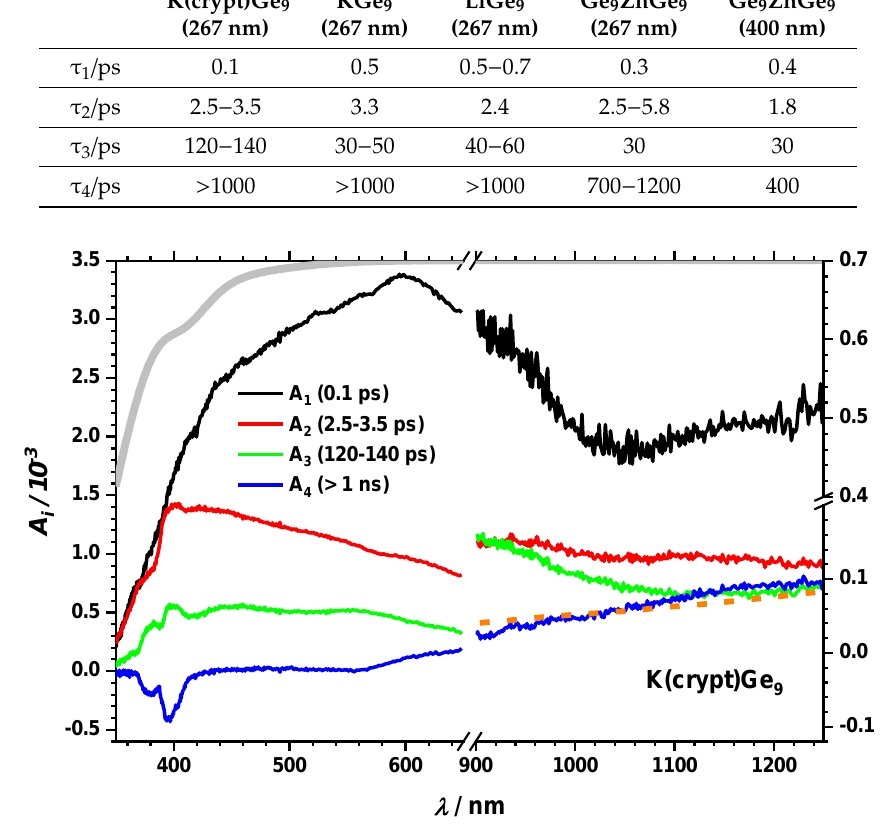
Figure 5. Decay associated spectra from global fit (further information is given in the SI) for K(crypt)Ge 9 in THF. A section of the absorption spectrum of the solvated electron in THF is given as an orange dashed line. Further spectra can be found in the SI Figure S2.